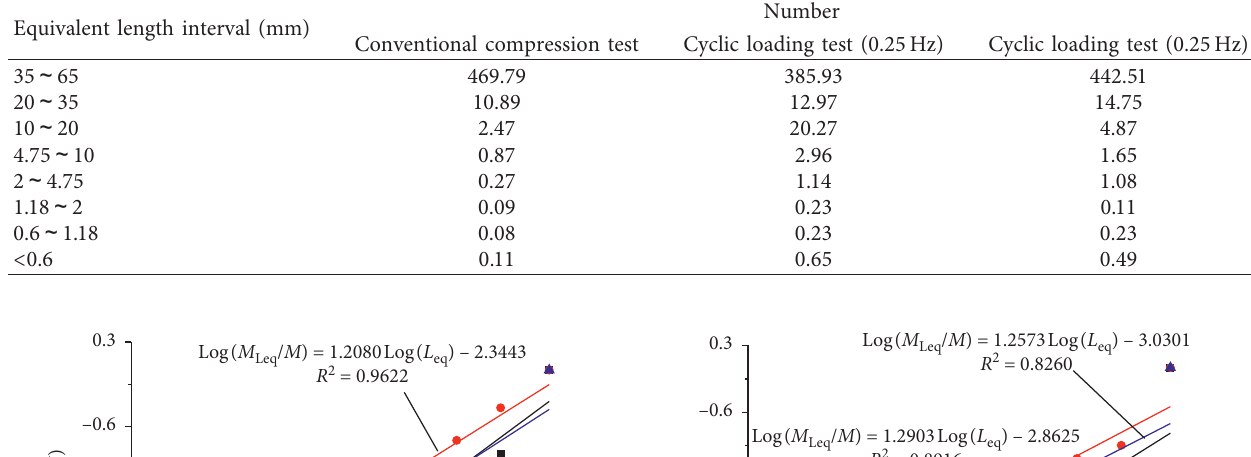
Table 9: Equivalent length interval and mass of limestone fragments under the confining pressure of 10MPa.